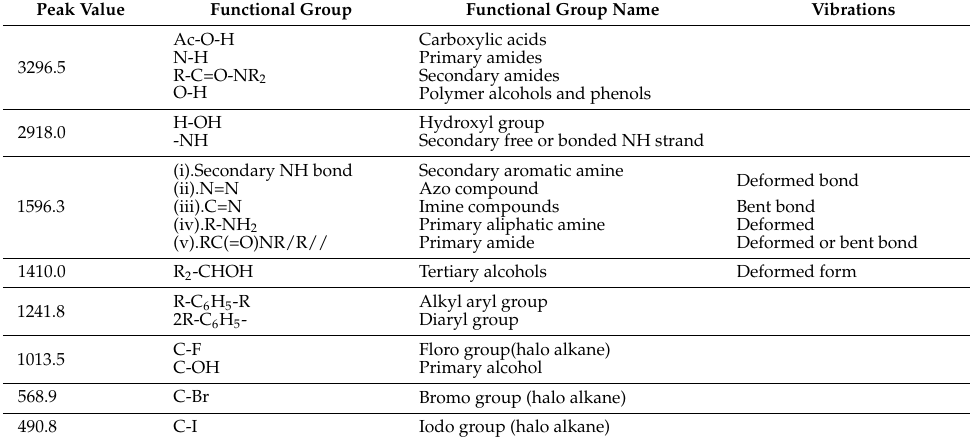
Table 1. Fourier-transform infrared spectroscopy (FTIR) peak values (cm − 1 ) and functional groups interpretation of H. crispum plant powder.